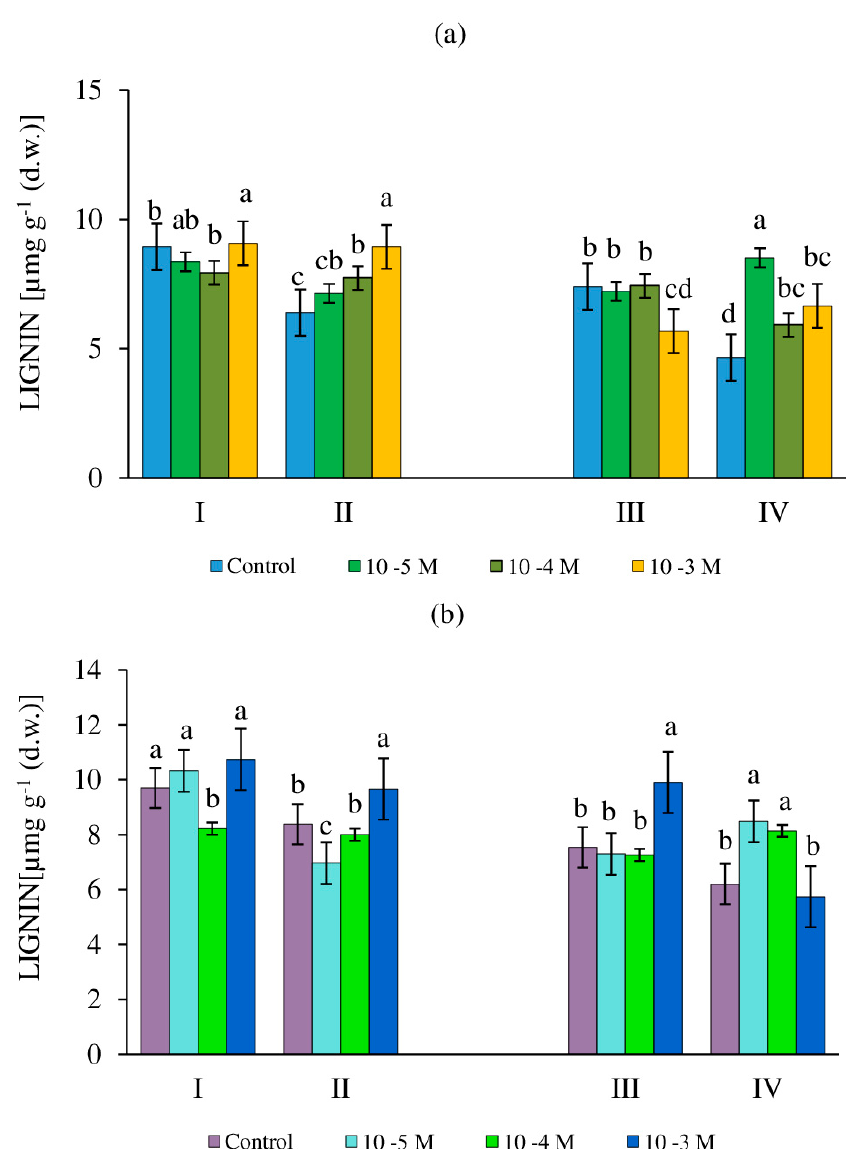
Figure 8. The content of lignin in callus cultures of tea plants at 24 days (I, II) and 36 days (III, IV) of age, grown in darkness ( a ) or light ( b ) and exposed to various concentrations of H 2 O 2 —0 (control), 0.01 mM, 0.1 mM, and 1 mM. Variants: I, III—rapid response of callus cells (2 h exposure to H 2 O 2 ); II, IV—delayed response of callus cells (48 h after exposure to H 2 O 2 ). Different letters indicate significant differences between exposure conditions ( p ≤ 0.05).